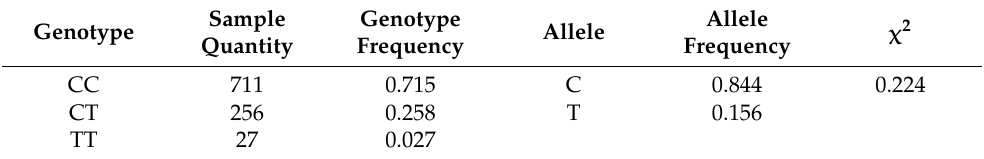
Table 2. Genotype and allele frequency of SNP rs81471943 in the EXOC4 gene in Duroc pigs.